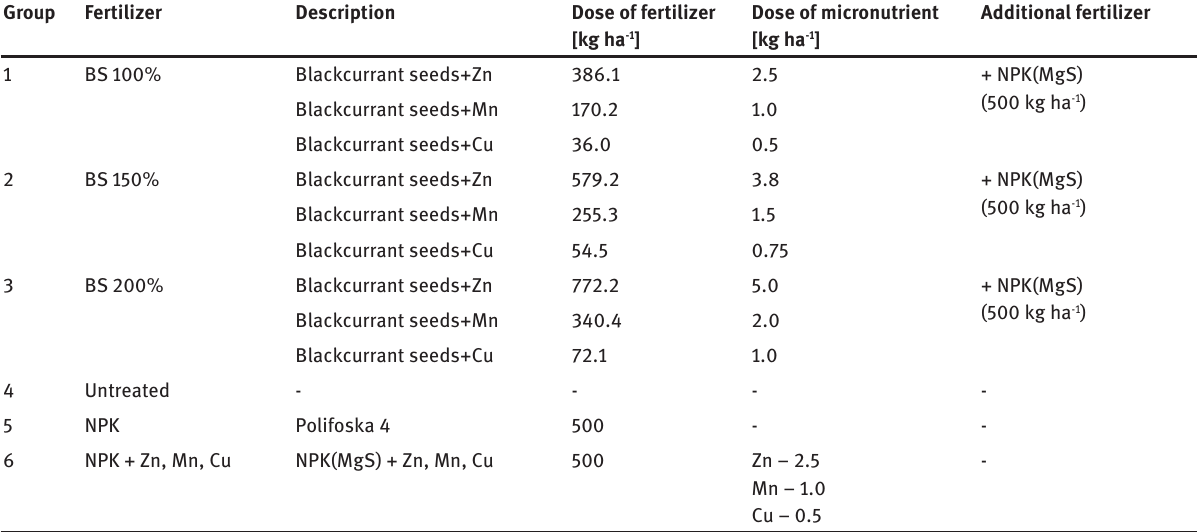
Table 1: Fertilization scheme – Fertilizers groups, fertilizer dosing [kg ha -1 ], and micronutrients doses [kg ha -1 ]. Group